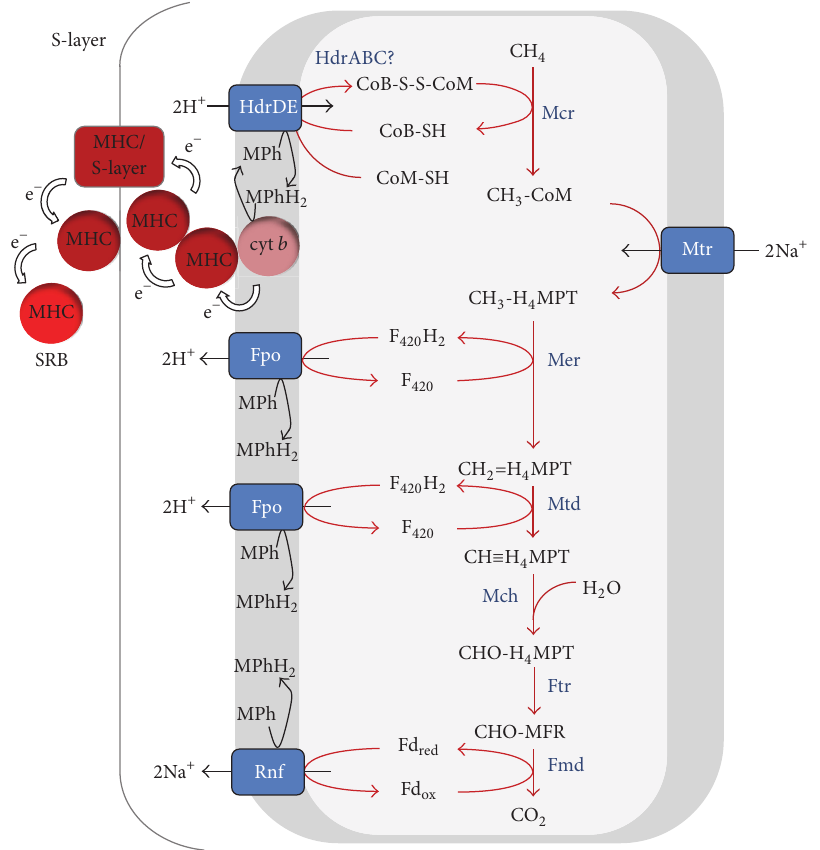
Figure 4: Methanotrophic pathway during S-AOM by ANME-2a [42]. Red lines indicate reversal of the hydrogenotrophic methanogenic pathway. See Table 3 for